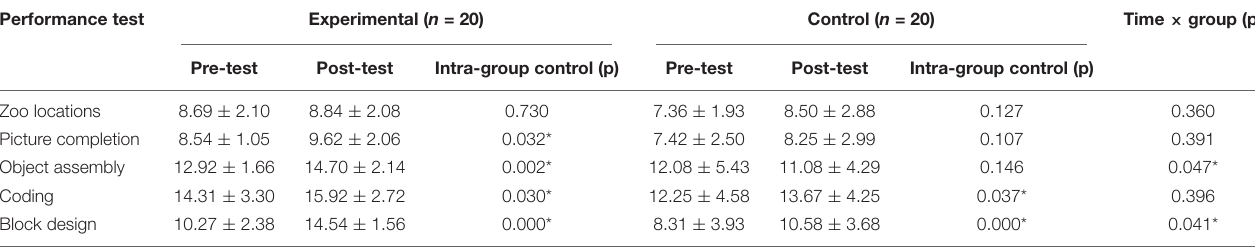
FIGURE 1 | Difference between pre- and post-test measures according to sex. (A) Scores of “Arithmetic” in verbal test items of Wechsler Intelligence Scale in experimental class before the experiment. (B) Scores of “Object Assembly” and “Coding” in performance test items of Wechsler Intelligence Scale in experimental class after the experiment. (C) Scores of “Performance IQ” in IQ scores of Wechsler Intelligence Scale in experimental class before and after the experiment. * p < 0.05. TABLE 4 | Scores of performance test items of Wechsler Intelligence Scale in experimental class and control class before and after the experiment. Performance test Experimental ( n = 20) Control ( n = 20) Time × group (p)